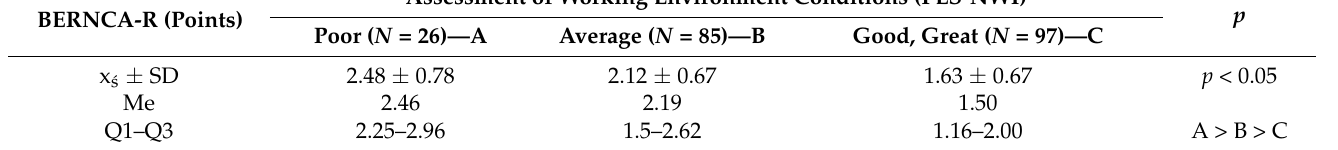
Table 4. Assessment of working conditions in the opinion of nurses and rationing of nursing care in the opinion of nurses.